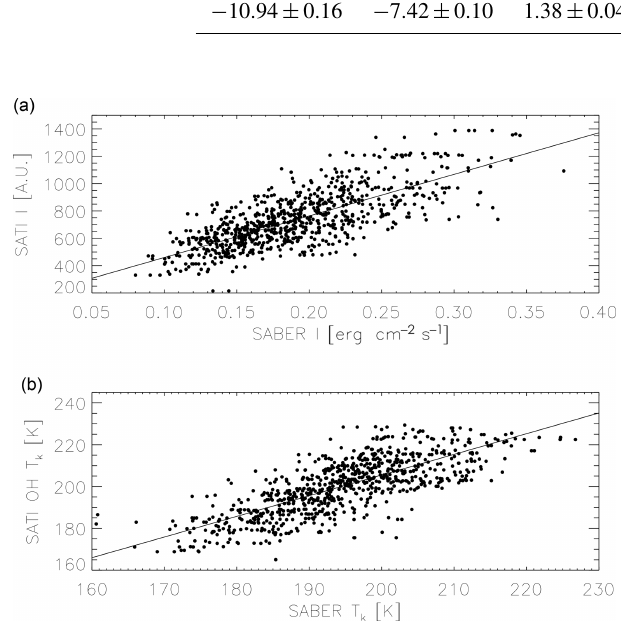
Figure 5. Colocated SABER vertically integrated OH VER vs. SATI OH intensities (a) and SABER OH-weighted temperatures vs. SATI OH rotational temperatures (b) . Solid line is the linear